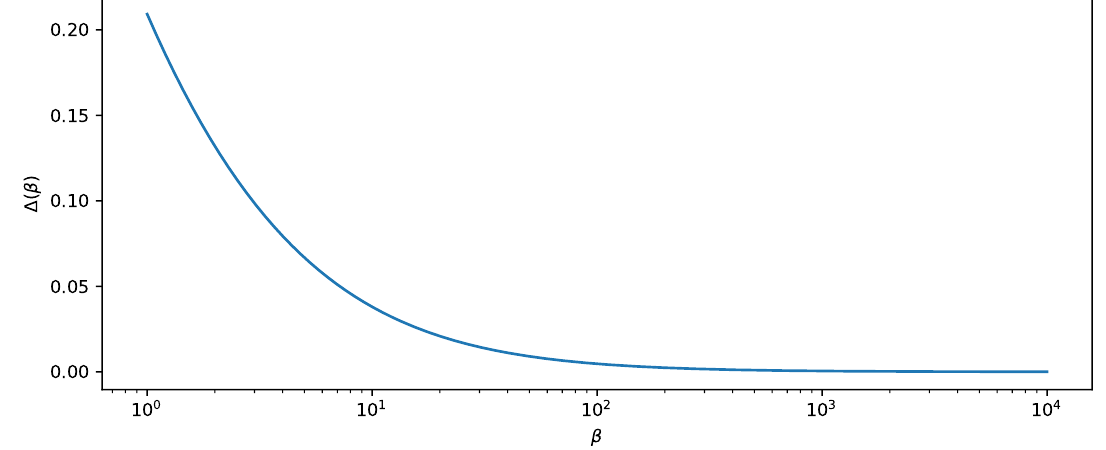
Figure 20. Dimensionless loop function ∆ as a function of β